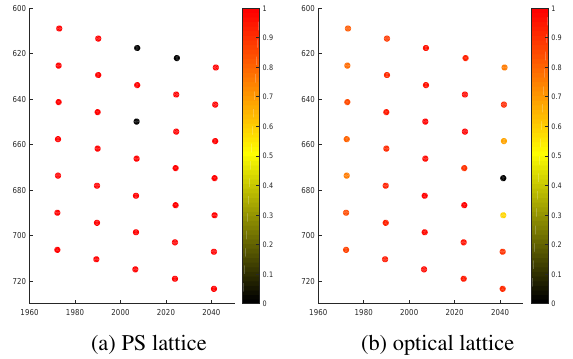
Figure 11. Corresponding points of the facade marked with a white arrow in Figure 7. Figure 10 is the corresponding close-up image. (a) are the points color-coded according to the reliability measure described in (Schack and Soergel, 2014). (b) shows the corresponding points but color-coded according to the correlation coefficient described in section